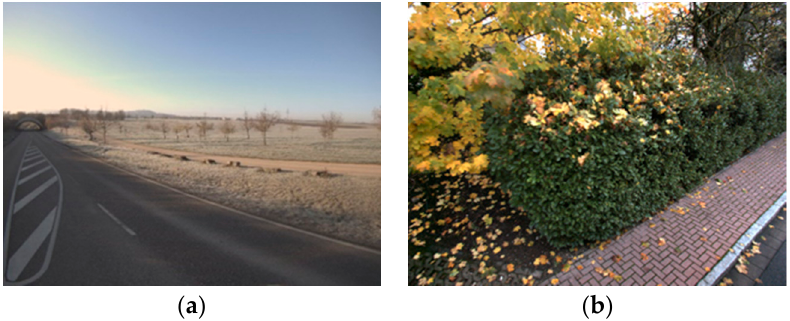
Figure 3. Seasonal variation of surface textures: (a) frost on a stretch of grass; (b) shedded leaves .